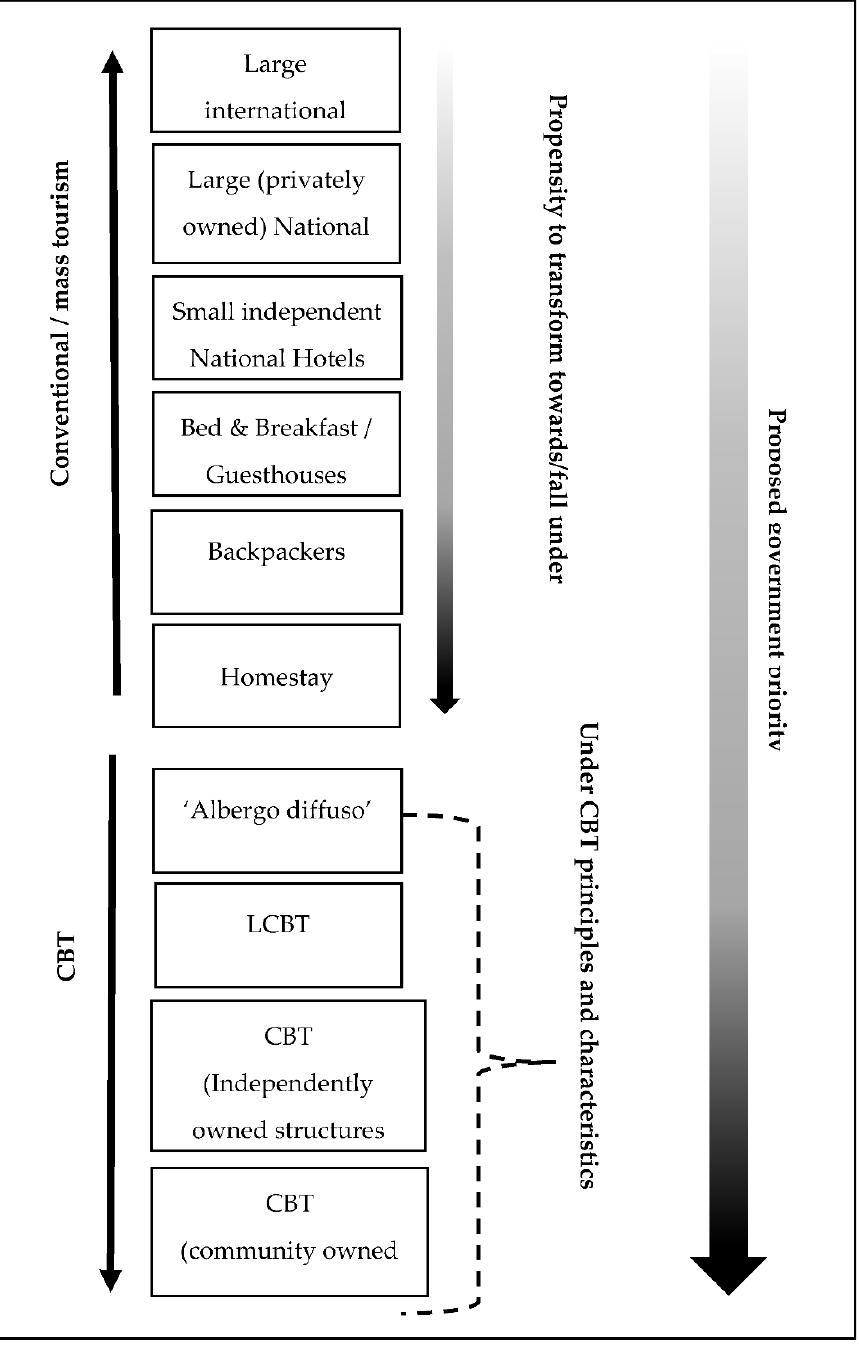
Figure 3. Accommodation typologies for transformation and/or inclusion of (or belonging to) CBT principles and characteristics. Source: authors’